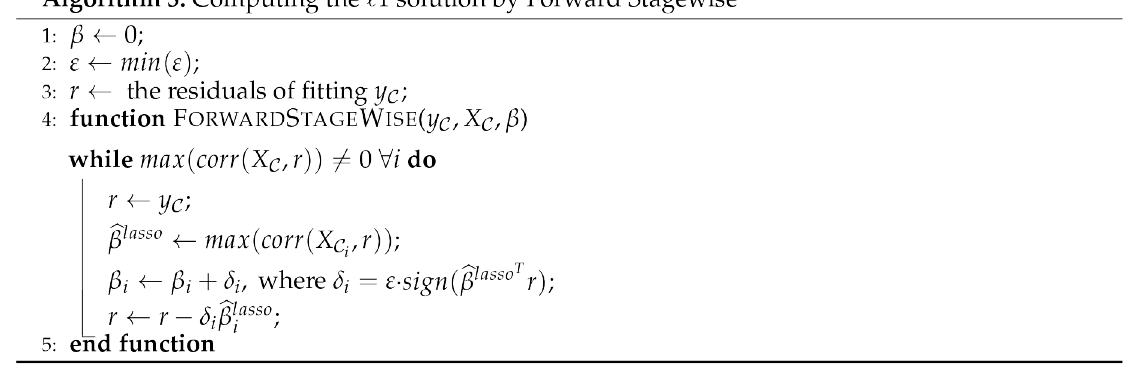
Algorithm 4: Predictions with regularized coefficients